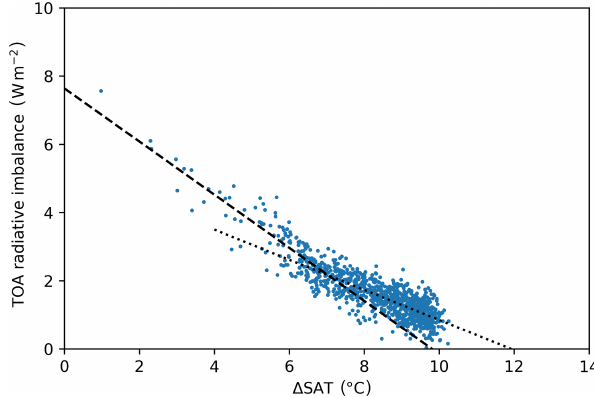
Figure 12. Regression of top-of-atmosphere (TOA) radiative im- balance versus change in global average surface skin temperature (SAT) in simulation abrupt4xCO2 based on annual means. The ref- erence is the average over the last 100 model years of the CMIP6 PI state E280C before branching off simulation abrupt4xCO2. Shown are annual mean values (dots) and two regressions: regression of the first 10% of the simulation illustrated via the dashed line and regression of the remainder of the data set illustrated via the dotted line. The intercept of the dotted line with the SAT anomaly axis es- timates the equilibrium response of the climate system to a quadru- pling of carbon dioxide. Equilibrium climate sensitivity is derived by halving this value.